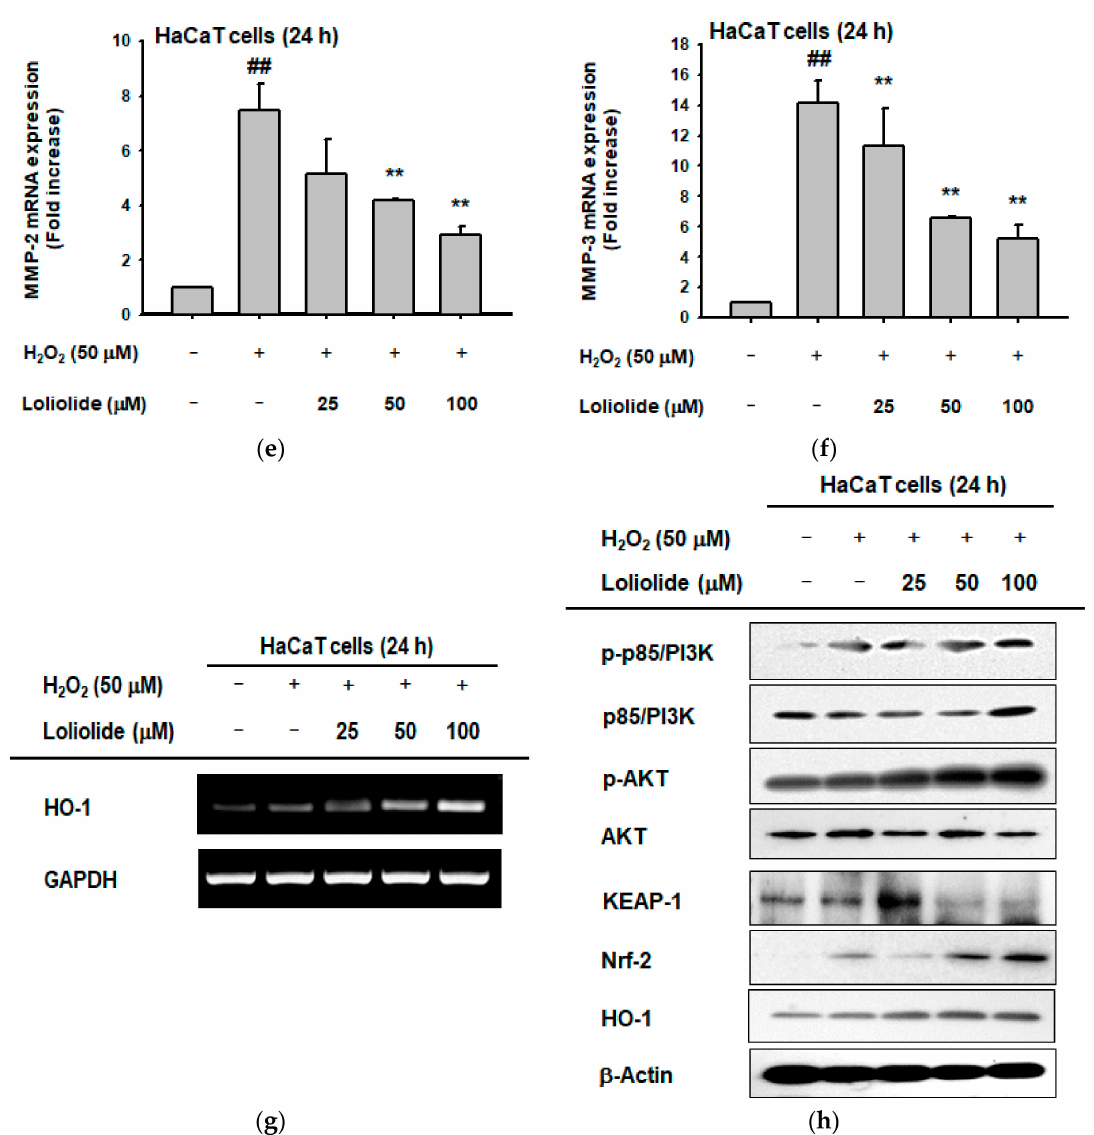
Figure 2. Oxidative stress-protective effect of loliolide on HaCaT cells. ( a ) Measurement of the ABTS radical scavenging activity of loliolide. ( b , c ) Viability of HaCaT cells treated with loliolide alone or loliolide plus H 2 O 2 as measured by MTT assay. ( d – f ) RT-PCR and real-time PCR analyses of MMP gene expression in HaCaT cells treated with loliolide and H 2 O 2 . ( g ) RT-PCR analysis of HO-1 gene expression in HaCaT cells treated with H 2 O 2 and loliolide. ( h ) Western blot analysis of the expression of proteins in the NRF2-KEAP1 signaling pathway in H 2 O 2 - and/or loliolide-treated HaCaT cells. Statistical significance ( a , c , e , f ) was evaluated using the Kruskal–Wallis/Mann–Whitney test. ## p < 0.05 compared with normal group and ** p < 0.01 compared with